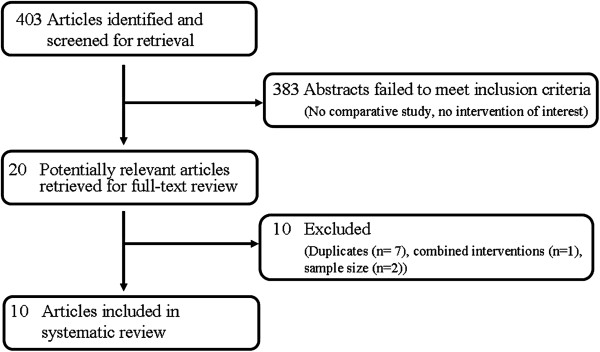
Study flow diagram.